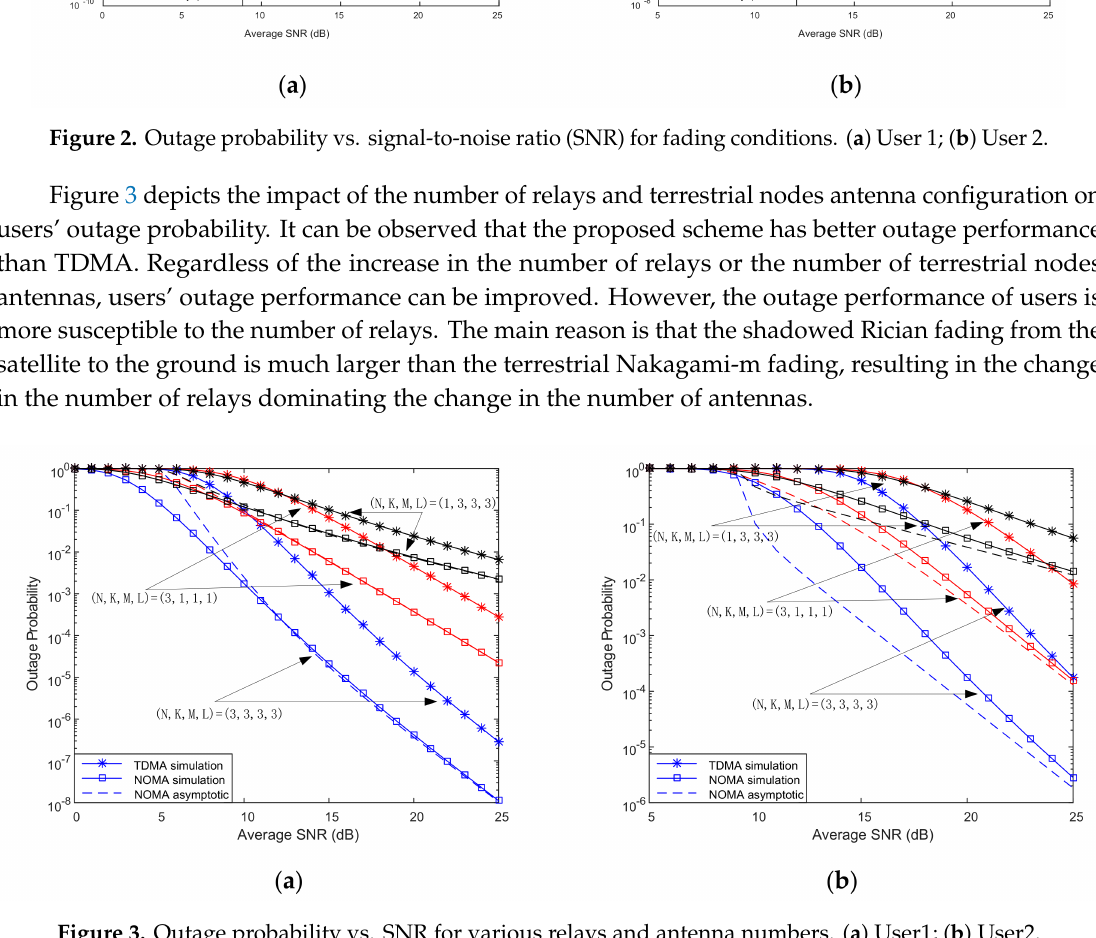
Figure 3. Outage probability vs. SNR for various relays and antenna numbers. ( a ) User1; ( b )